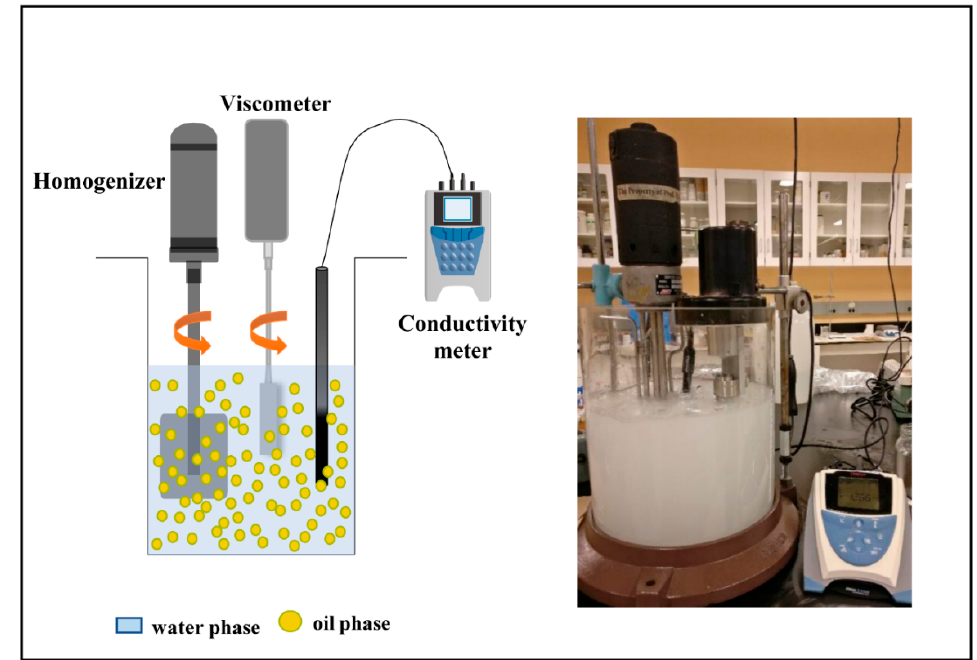
Figure 2. Schematic diagram and photograph of the experimental set-up for the in-situ measurement of the viscosity of emulsions.